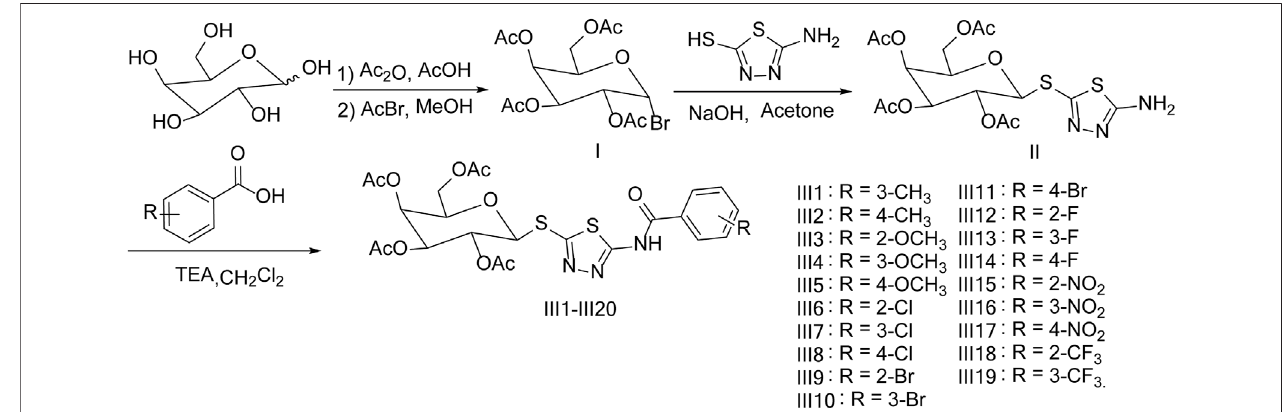
FIGURE 1 | Synthetic route of the target compounds Ⅲ 1 – Ⅲ